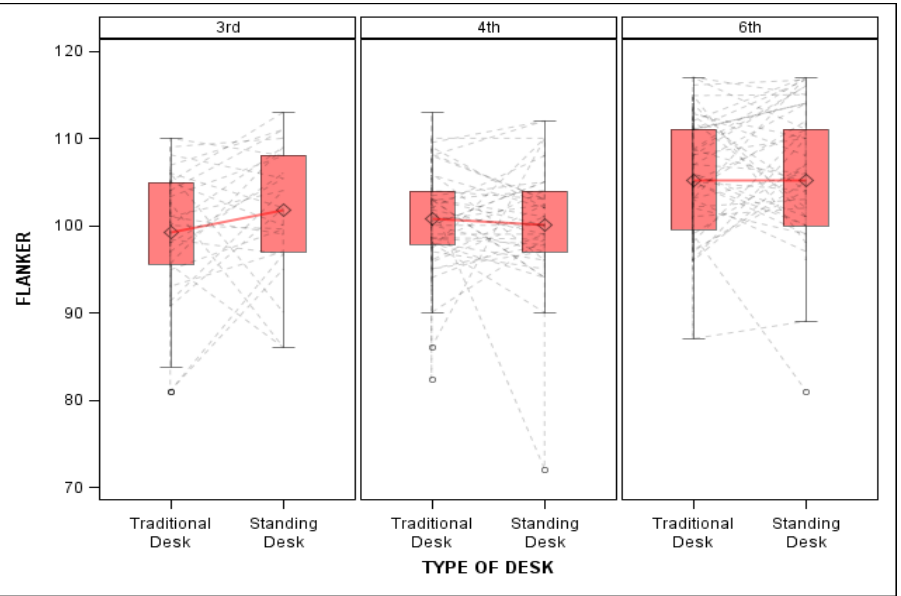
Figure 1. Flanker performance by grade between traditional and stand-biased desks. Figure shows mean flanker performance by grade. Third graders in stand-biased desks showed increased flanker performance compared to their traditional desk using peers.